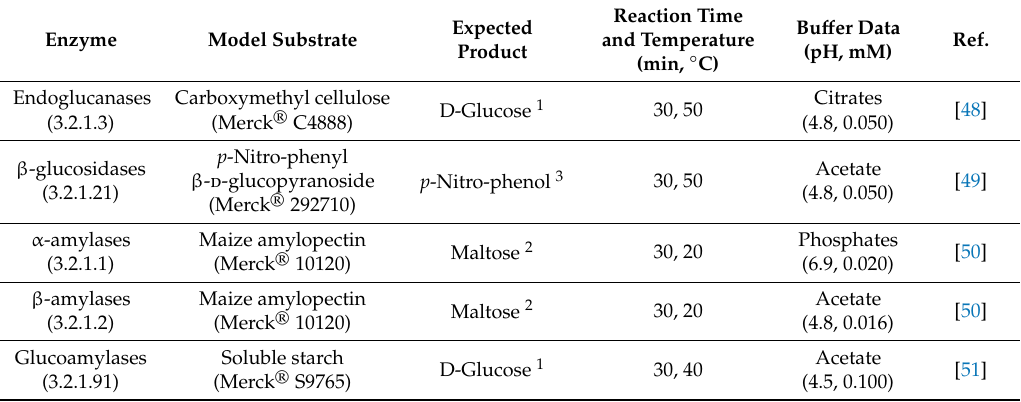
Table 4. Conditions for enzymatic assays and reference